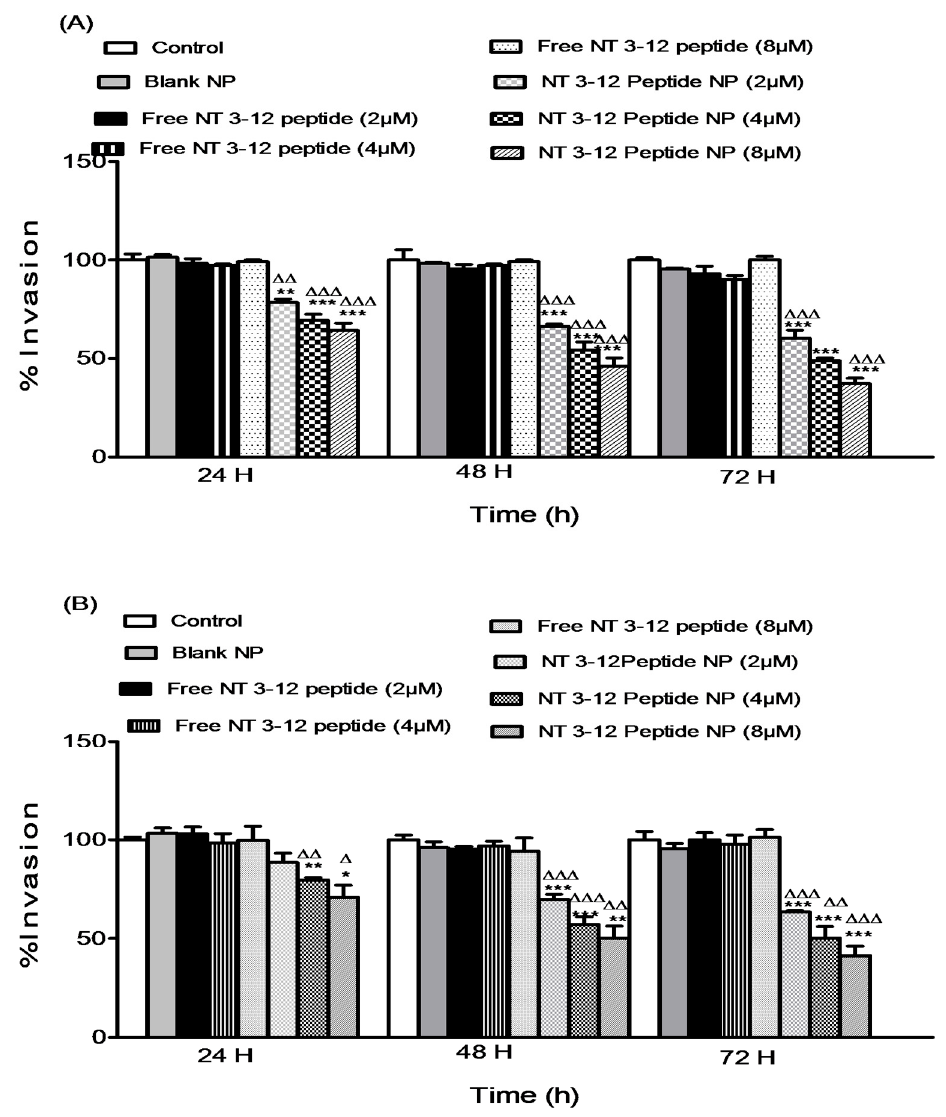
Figure 6. Effect of different doses of free N 3–12 peptide and N 3–12 peptide-loaded NPs on MDA-MB-231 invasion ( A ) and A549 invasion ( B ). Values are mean ± SEM with n = 3. * p < 0.05, ** p < 0.01, *** p < 0.001 compared with Control and blank NP. Δ p < 0.05, ΔΔ p < 0.01, ΔΔΔ p < 0.001 compared with the same dose of free peptide.